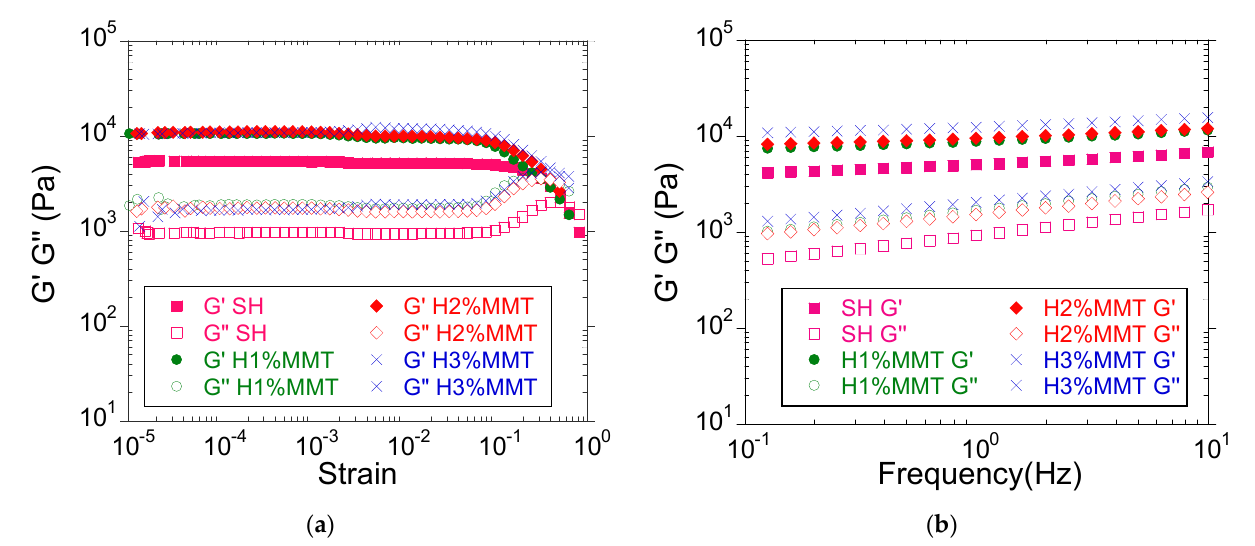
Figure 8. The influence of the MMT concentration on the viscoelastic properties of PMAA hydrogels ( a ) Amplitude sweep measurements ( b ) Frequency sweep measurements. SH: 10%MAA, 2 mol%BIS based on MAA, 0%MMT. Table 7. Dependence of the viscoelastic moduli (frequency sweep measurements) and some structural network parameters on MMT concentration a .